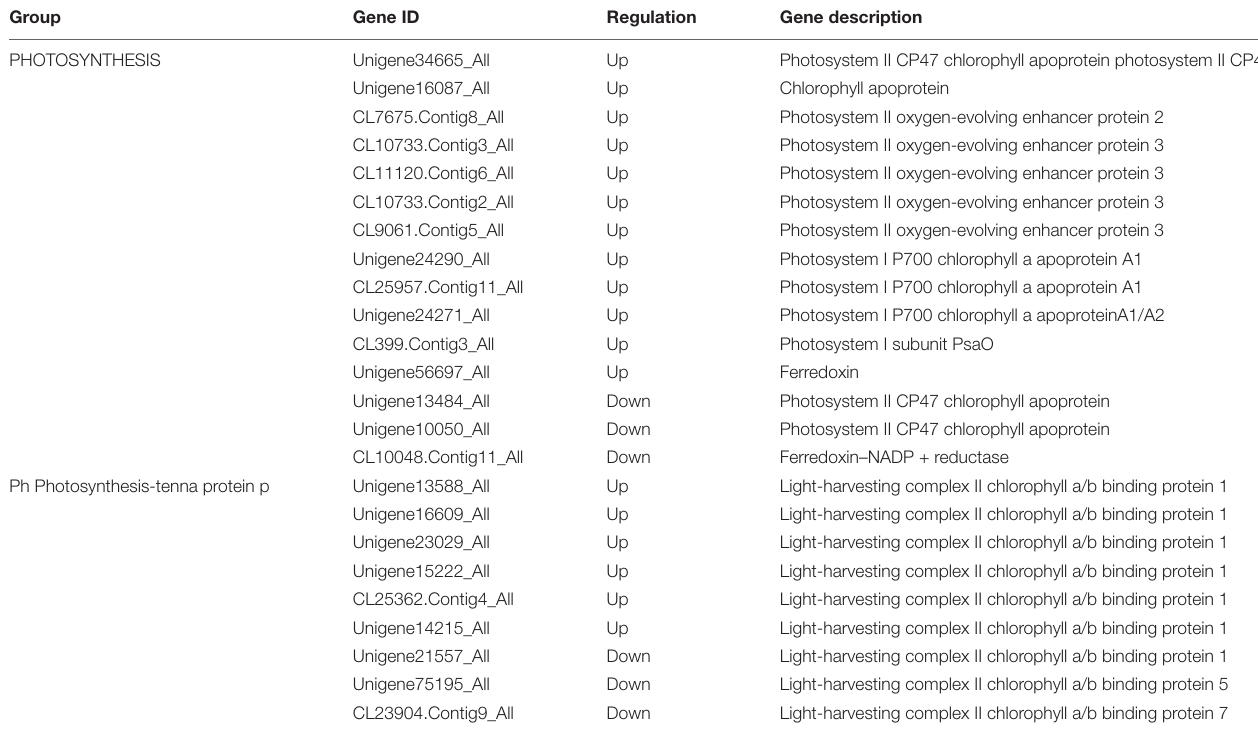
TABLE 4 | DEGs associated with photosynthesis.